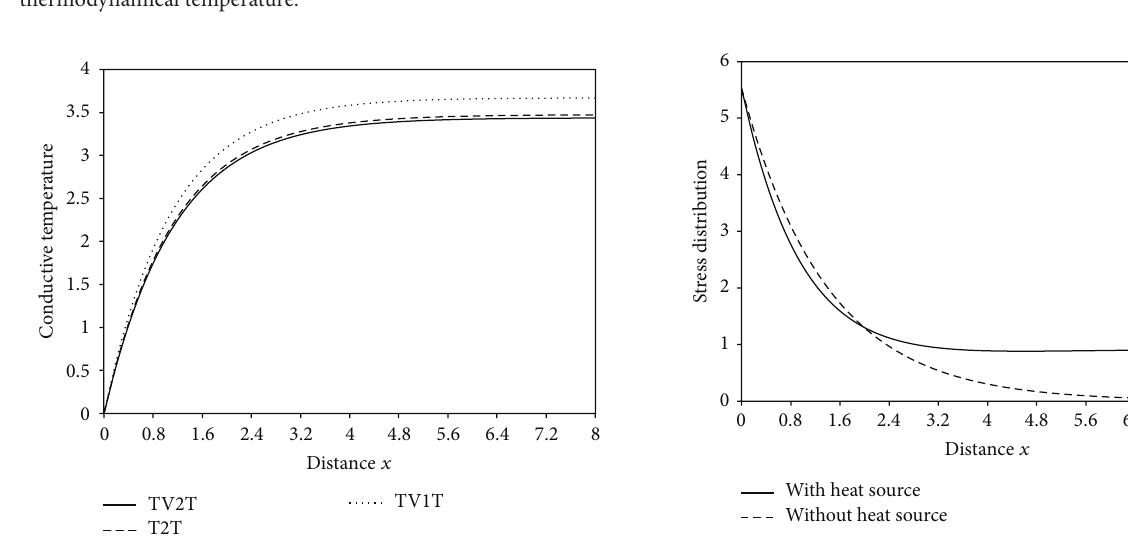
Figure 13: Distribution of displacement with distance 𝑥 .